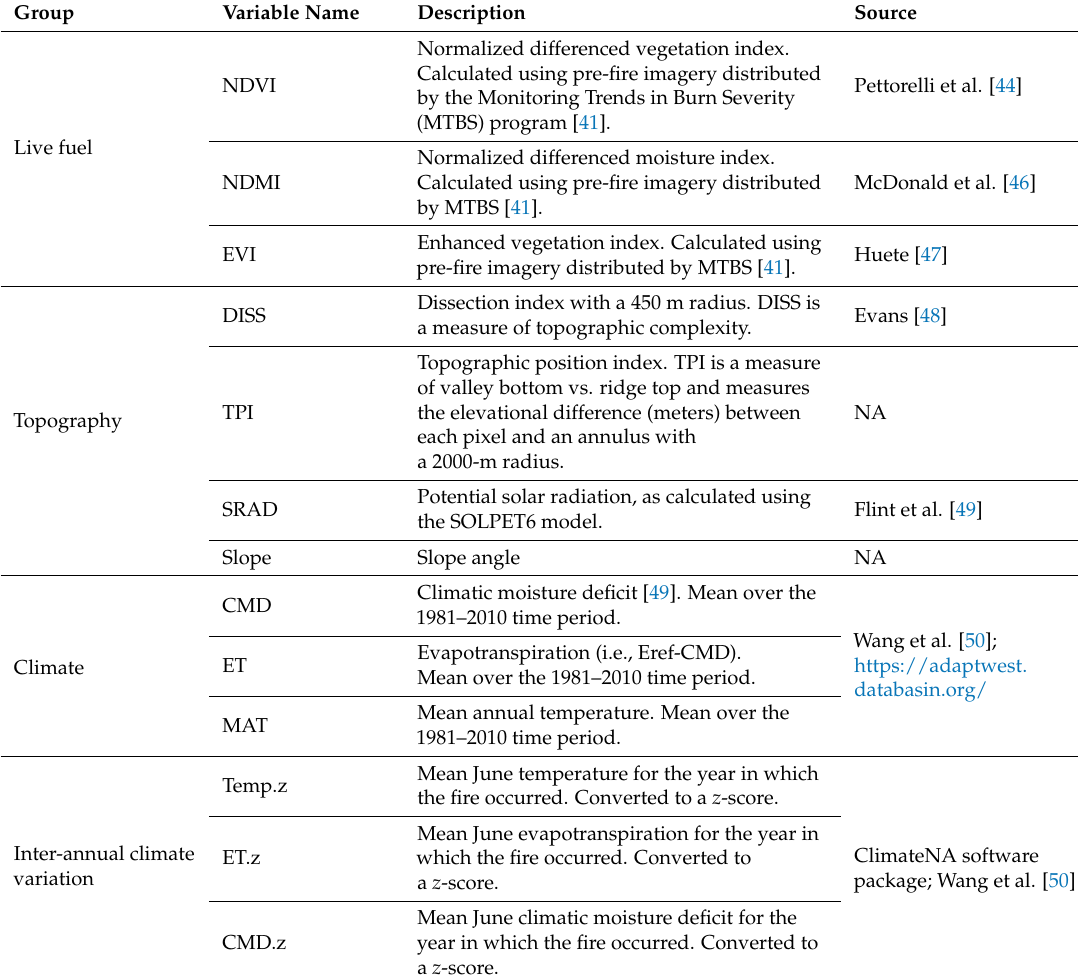
Table 1. Variables evaluated as predictors in modeling the probability of low-severity fire in forests of the southwestern